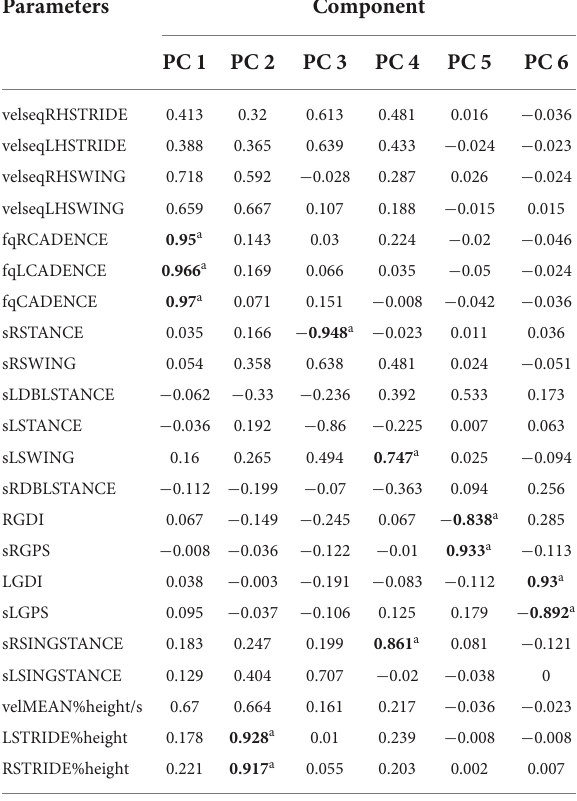
TABLE 4 Results of principal component analysis of